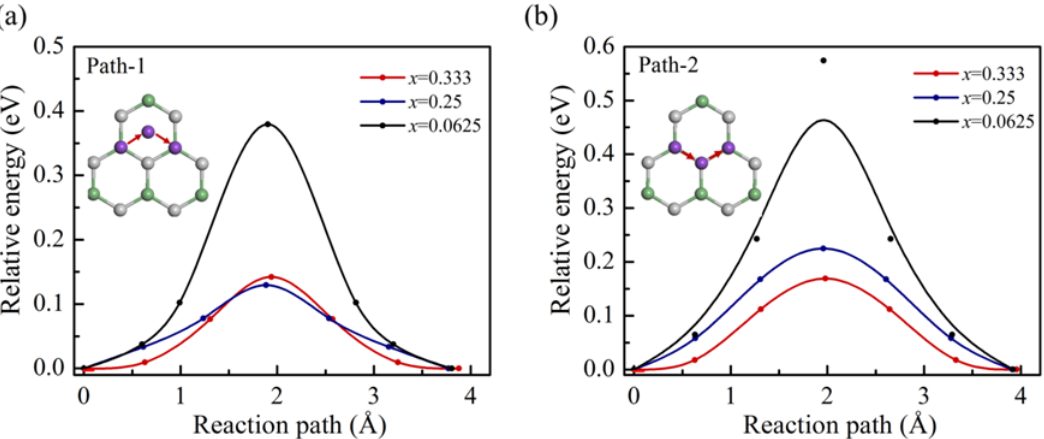
Figure 5. The diffusion barrier profiles of one K ion migration on g-GeC along ( a ) path-1 (Ge-H h -Ge) and ( b ) path-2 (Ge-C-Ge) at different concentrations.